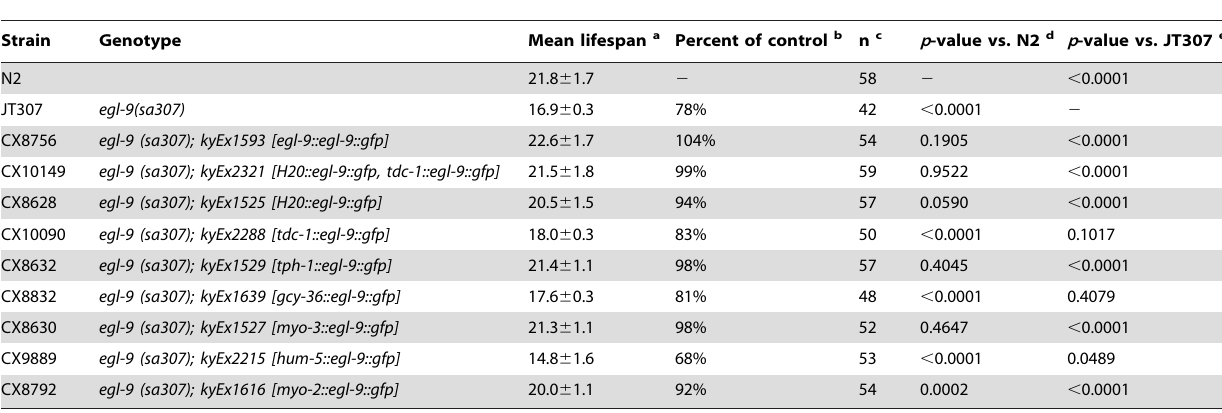
Table 3. HIF-1 functions in specific neurons and muscles to modulate DR-dependent lifespan extension.